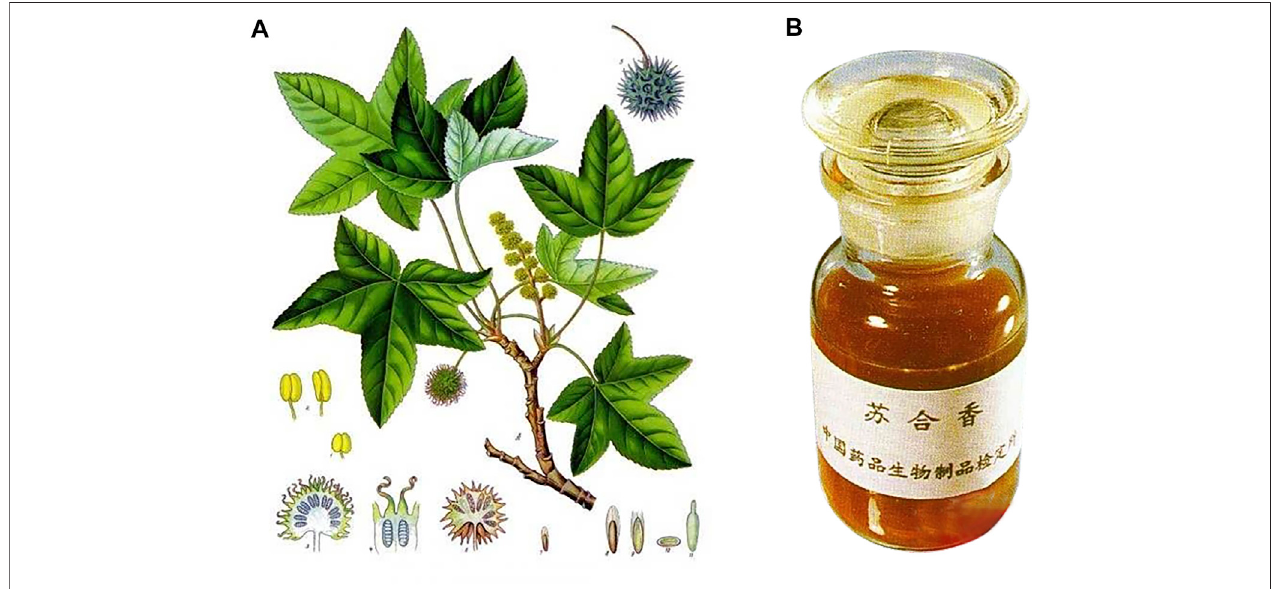
FIGURE 2 | Branches of storax (A) ; storax oil (B) (https://image.baidu.com/).